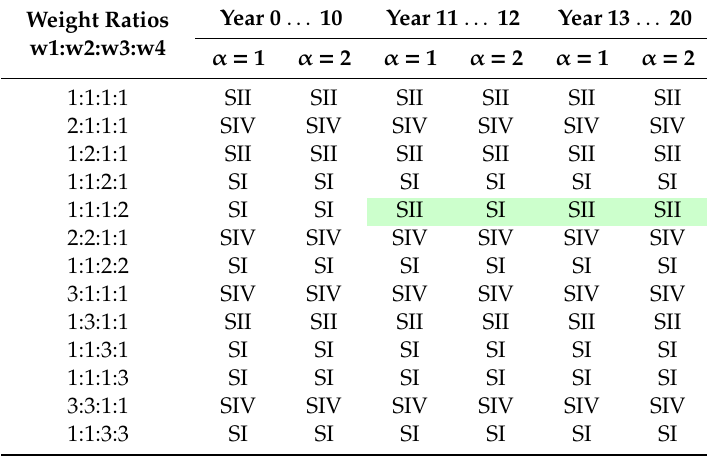
Table 4. Results of the multi-criteria analysis of load distribution taking into account a decrease in the performance of PV installation alone over the time of